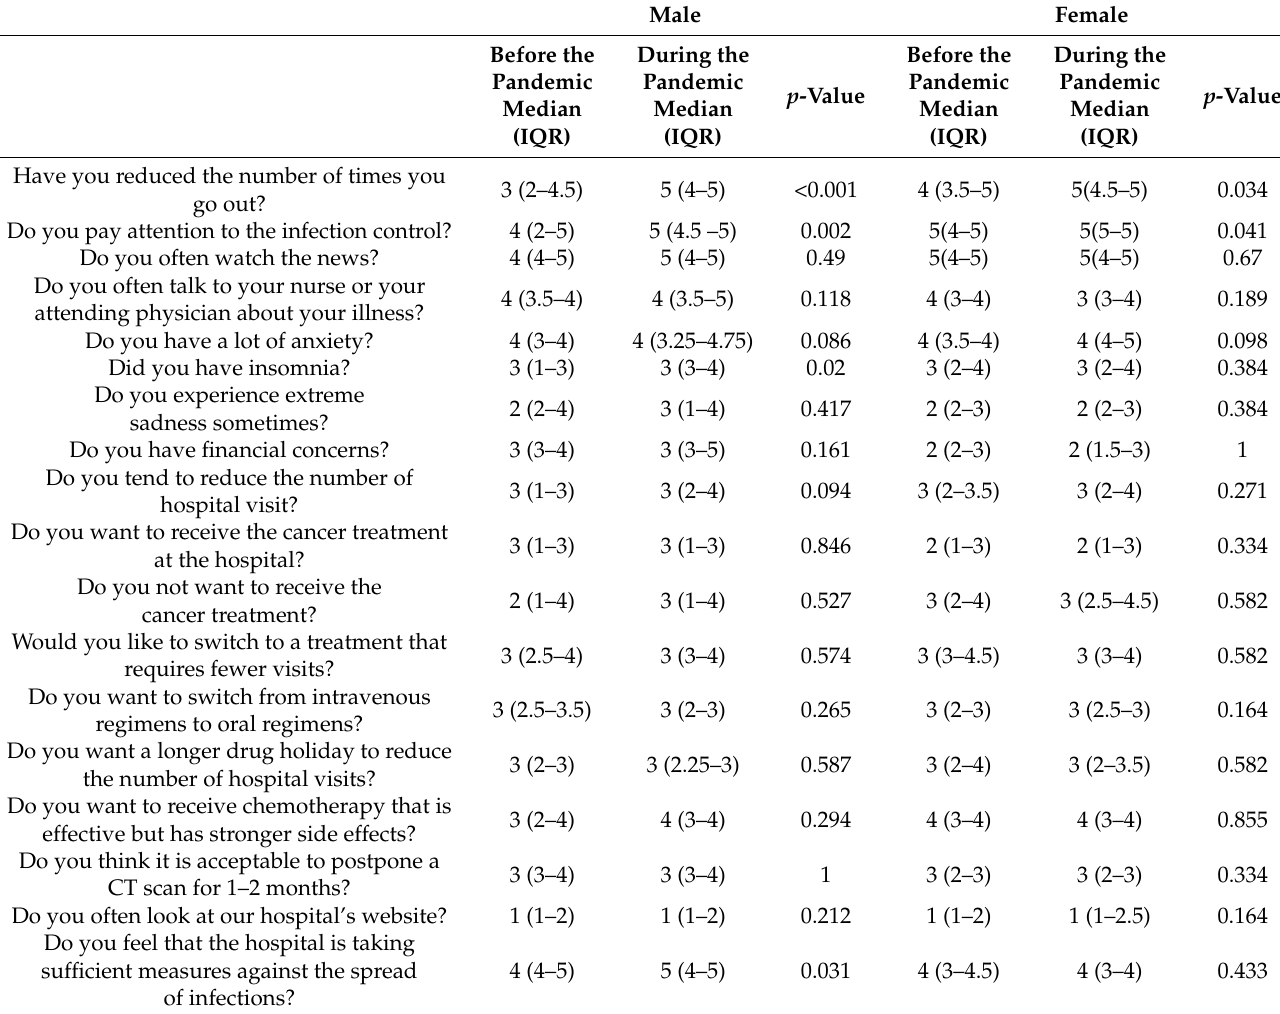
Table 4. The distribution of the responses by sex (male or female) to the questions.